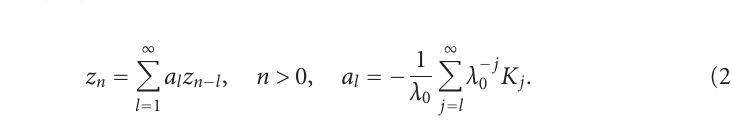
Di ff erent su ffi cient conditions for asymptotic stability of the trivial solution of di ff erence Volterra equation type of (2.1) were obtained in [1–4, 13] via the general method of Lyapunov functionals